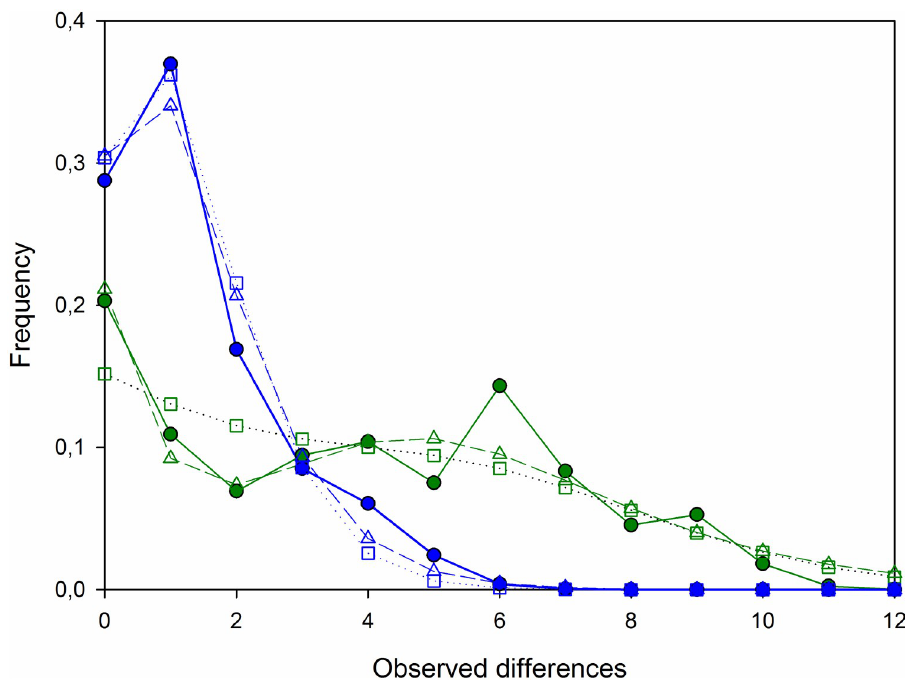
Fig 5. Mismatch distributions of two main haplogroups in northeastern Atlantic Octopus vulgaris . Solid lines (green, haplogroup α ) and blue (haplogroup β ); squares and dotted lines depict a spatial model, and triangles and dashed lines depict a sudden expansion